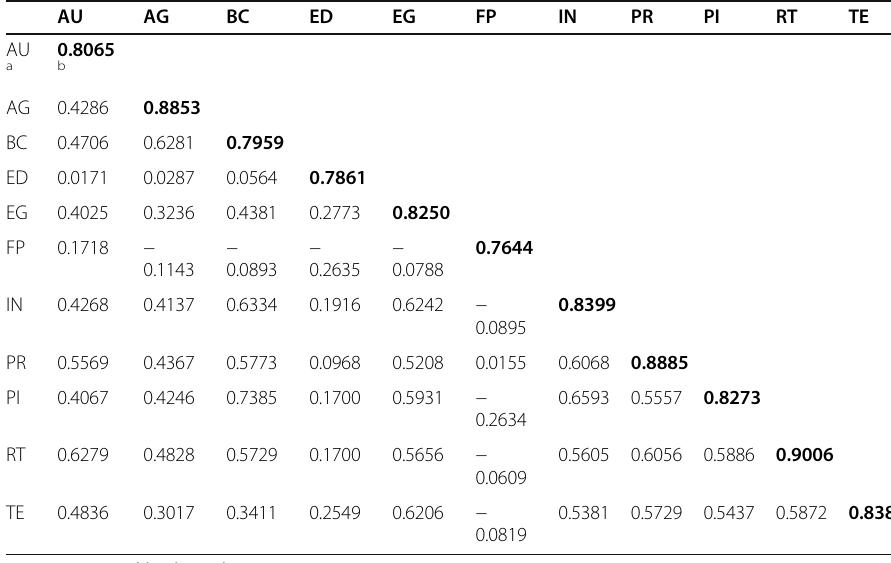
Table 5 Discriminant validity — Fornell-Larcker